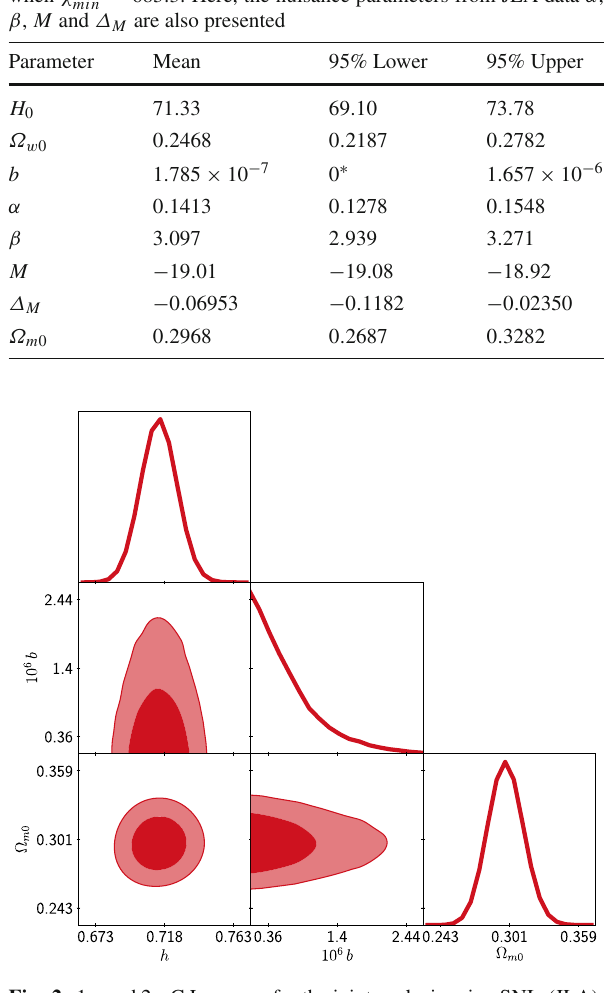
Fig. 2 1 σ and 2 σ C.L. curves for the joint analysis using SNIa (JLA), H 0 and BAO data